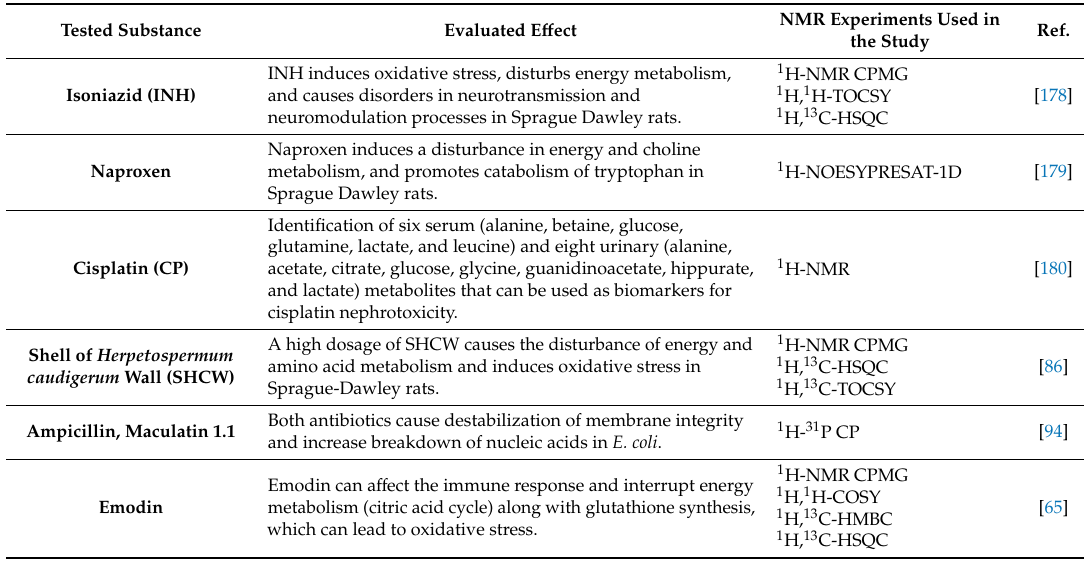
Table 1. Recent pharmacological studies complemented with NMR approaches for evaluating the e ffi cacy / safety of new or existing